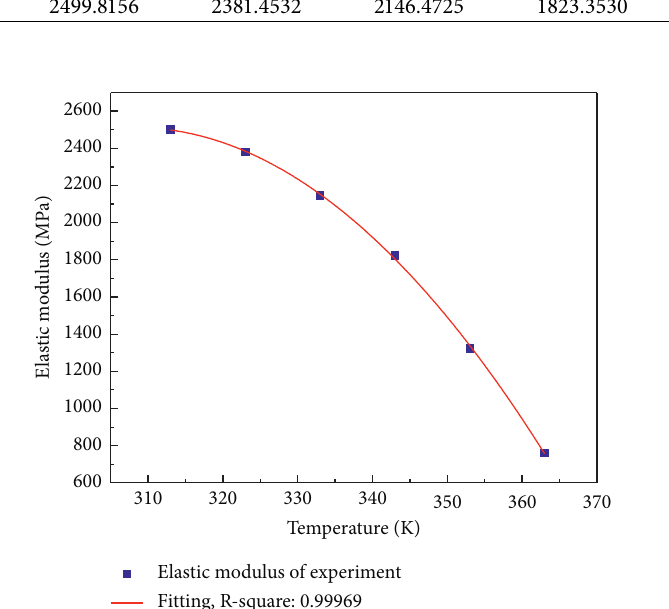
Figure 2: Fitting curve of the elastic modulus at different temperatures.